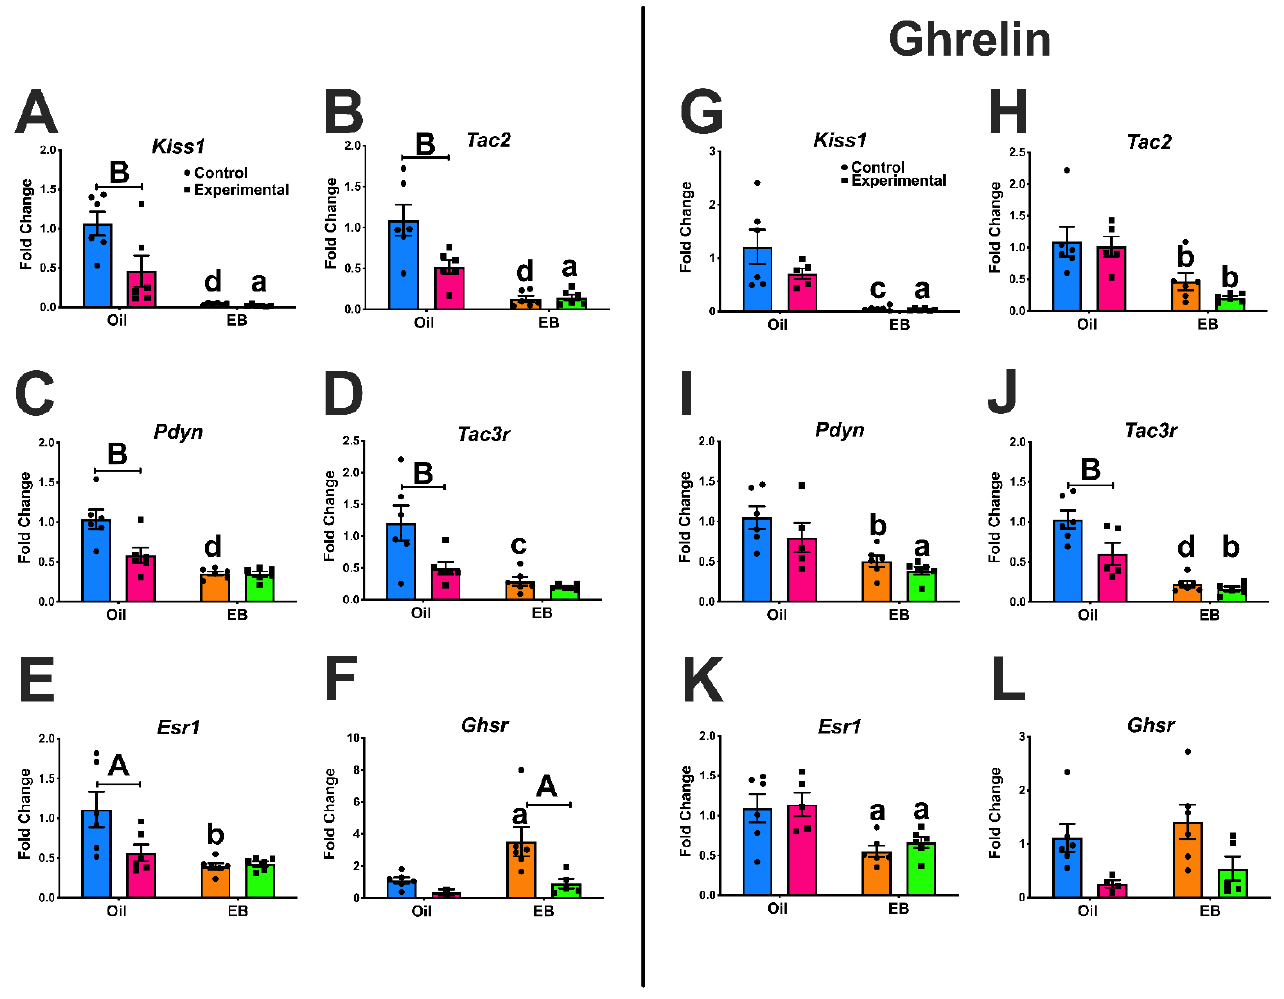
Figure 1. Arcuate gene expression in OVX control and Kiss1-GHSR KO females with or without E2 replacement ( A – F ) and with ghrelin injection ( G – L ): ( A , G ) Kiss1 ; ( B , H ) Tac2 ; ( C , I ) Pdyn ; and ( D , J ) E2 replacement ( A – F ) and with ghrelin injection ( G – L ): ( A , G ) Kiss1 ; ( B , H ) Tac2 ; ( C , I ) Pdyn ; and Tac3r ; ( E , K ) Esr1 ; and ( F , L ) Ghsr . For all graphs, data were analyzed by a multi-factorial ANOVA ( D , J ) Tac3r ; ( E , K ) Esr1 ; and ( F , L ) Ghsr . For all graphs, data were analyzed by a multi-factorial ANOVA (steroid, genotype) with post hoc Holm – Sidak ’s multiple comparison test. Lower case letters denote (steroid, genotype) with post hoc Holm–Sidak’s multiple comparison test. Lower case letters de- steroid differences within genotype, uppercase letters above capped lines denote genotype effects note steroid differences within genotype, uppercase letters above capped lines denote genotype (A/a = p < 0.05; B/b = p < 0.01; C/c = p < 0.001; D/d = p < 0.0001). Data is represented as mean ± SEM. effects (A/a = p < 0.05; B/b = p < 0.01; C/c = p < 0.001; D/d = p < 0.0001). Data is represented Ghrelin injection was given IP at 1 mg/kg 12 h prior to sacrifice. Statistics are indicated as follows: as mean ± SEM. Ghrelin injection was given IP at 1 mg/kg 12 h prior to sacrifice. Statistics are indicated as follows: Kiss1 ( A ): steroid: F(1,20) = 34.34; genotype: F(1,20) = 6.385; interaction of steroid*genotype: F(1,20) = 5.532. Tac2 ( B ): steroid: F(1,20) = 39.06; genotype: F(1,20) = 6.661; interac- tion of steroid*genotype: F(1,20) = 7.573. Pdyn ( C ): steroid: F(1,20) = 32.32; genotype: F(1,20) =